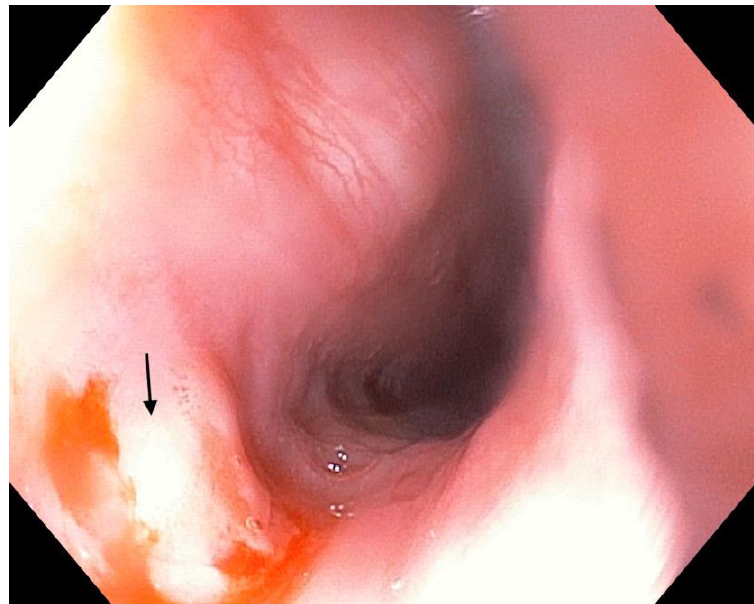
Figure 1. Macroscopic aspect of the inlet patch .